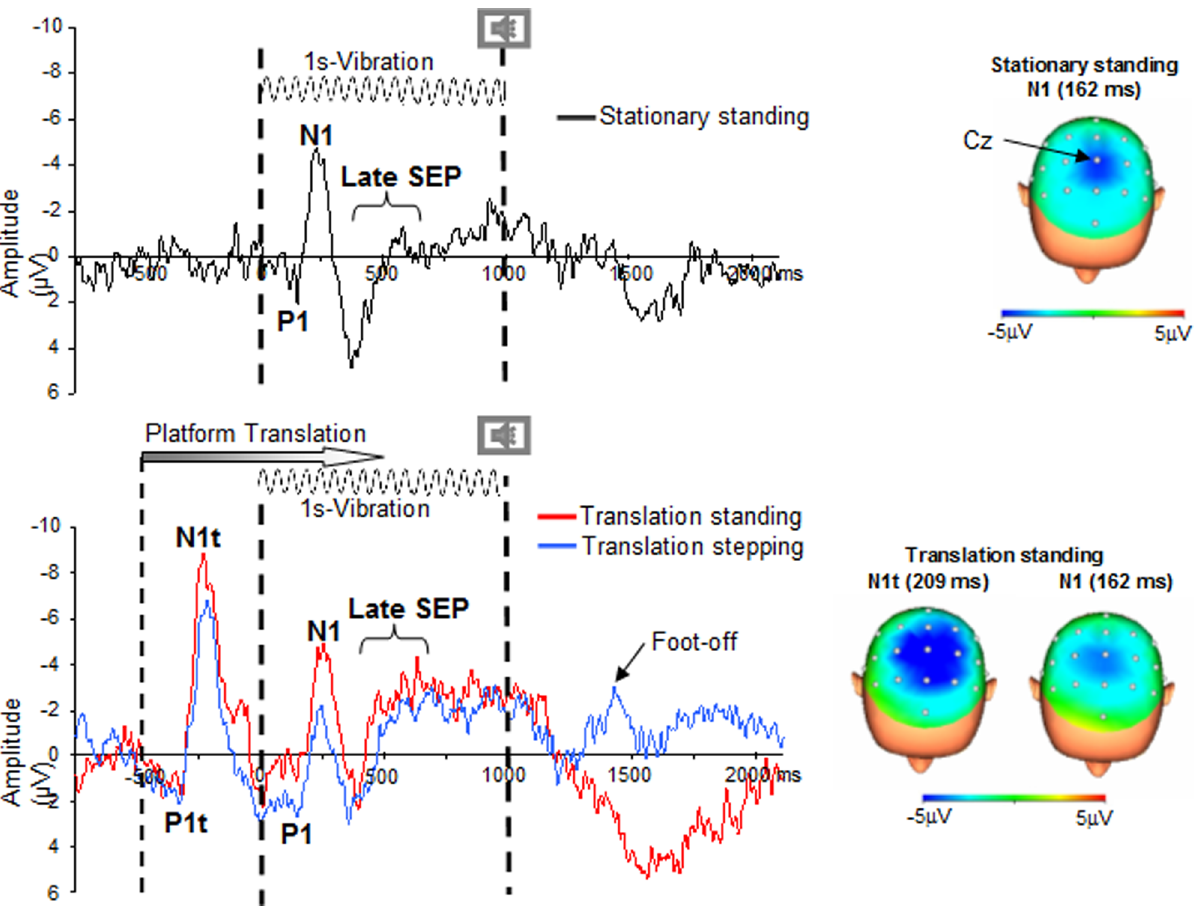
Figure 2. SEPs recordings. Grand-Average for 6 participants recorded at electrode Cz for the Stationnary standing condition (Top panel), Translation standing and Translation stepping conditions (Bottom panel). The vertical dotted lines indicate the vibration onset and offset, the second vertical dotted line also indicates imperative tone stimulus for step execution. For both Translation conditions, the vertical dash-dotted line indicates the translation onset (occurring 500 ms before vibration). The ‘‘foot-off’’ indicates the onset of the stepping movement computed on the foot vertical velocity. The scalp topography was shown at the peak negativity for the participants average in the Sationary and Translation